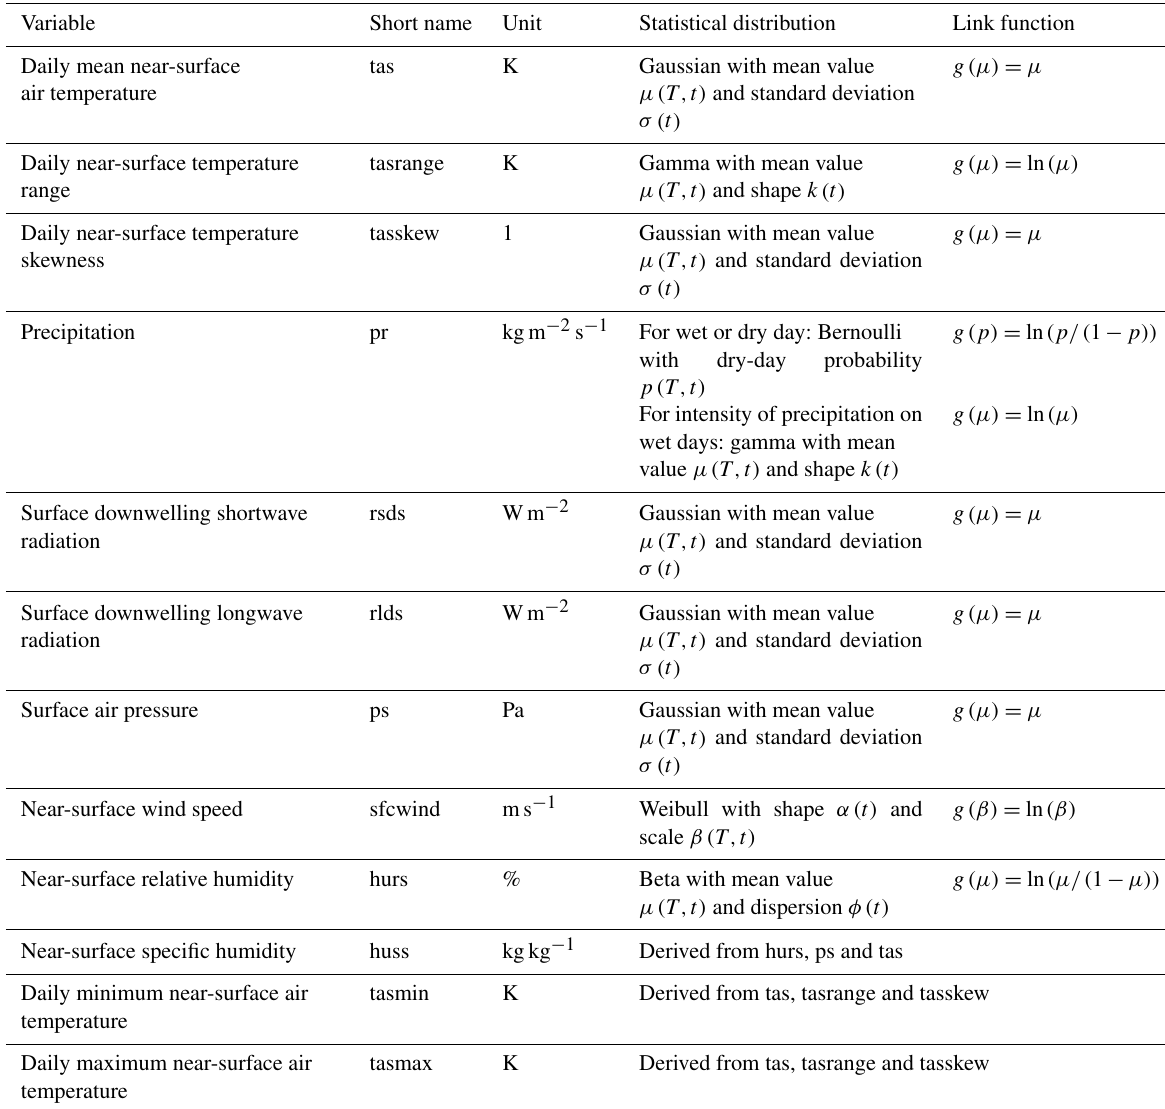
Table 1. Climate variables covered by ISIMIP3a counterfactual climate datasets. Listed are each variable’s short name and unit as well as the statistical distribution and link function used for detrending it. Also specified is the dependence of the distribution parameters on GMT change, T , and day of the year, t , as used in our GLM. The variables tasrange and tasskew are auxiliary variables used to detrend tasmin and